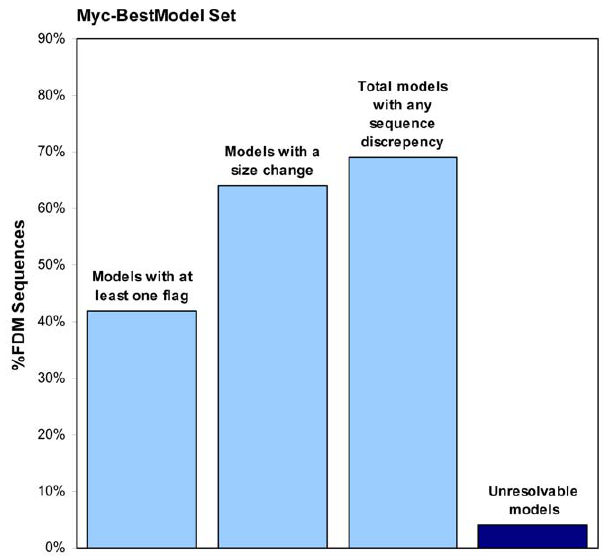
Figure 3. Summary of structural annotation outcome for the Myc-BestModel